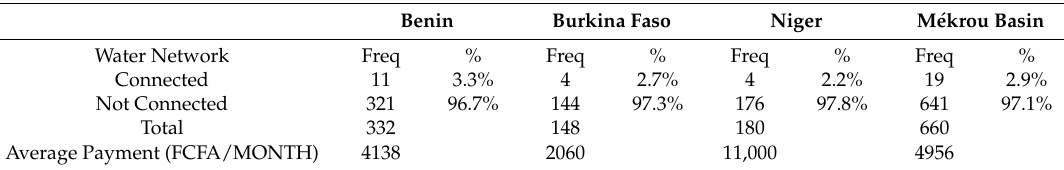
Table 1. Connection in the water network and actual